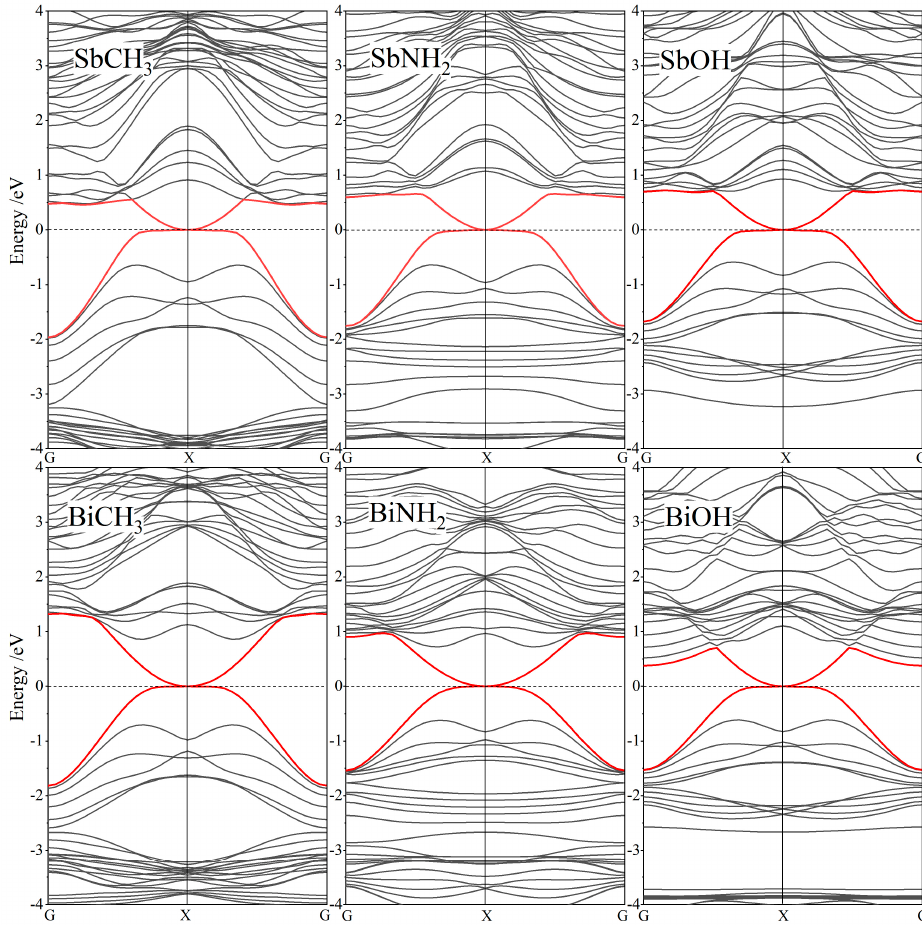
Figure 4. The SOC-incorporated band structures of SbXH n ( top panels ) and BiXH n ( bottom panels ) zigzag nanoribbons in reference to Fermi level as energy zero (horizontal dash lines).